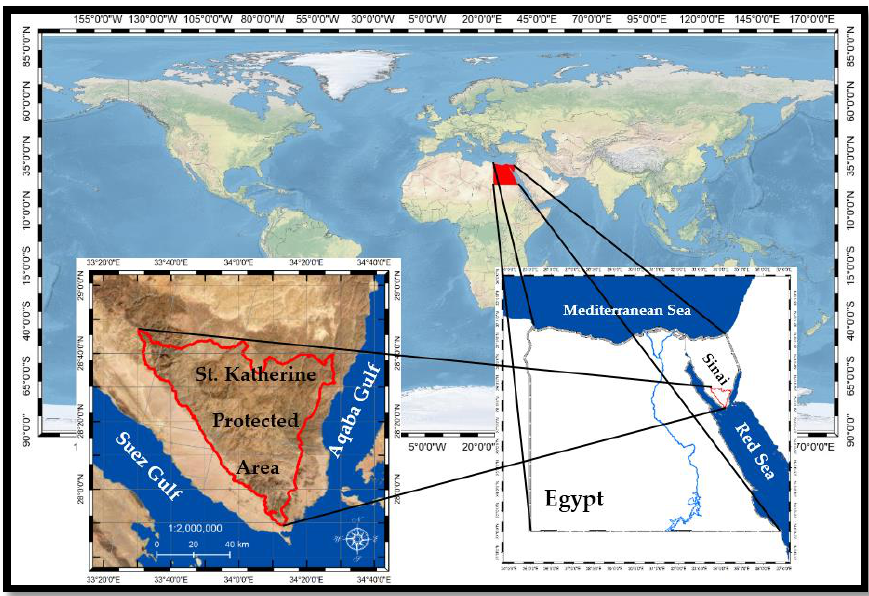
Figure 10. Study area map for Saint Katherine protected area, Sinai, Egypt (Using Landsat8 OLI 2019, Path/Row 178/39).